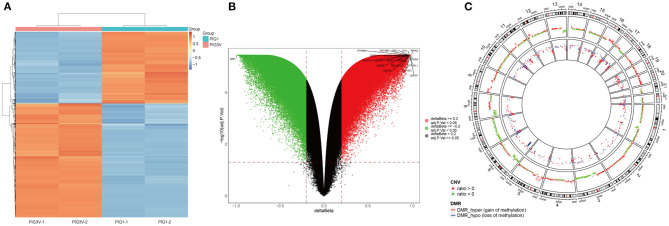
(A) The heat map, (B) the Volcano map analysis of genes with differential methylation between vitiligo melanocyte and normal melanocyte. (C) A joint analysis of CNV results and differential methylation sites performde by the Circos diagram. CNV and the outermost circle represent chromosome regions, and the second inward circle represents the CNV copy number (red represents ratio > 0, green represents ratio < 0), The inner circle represents the DMR area.